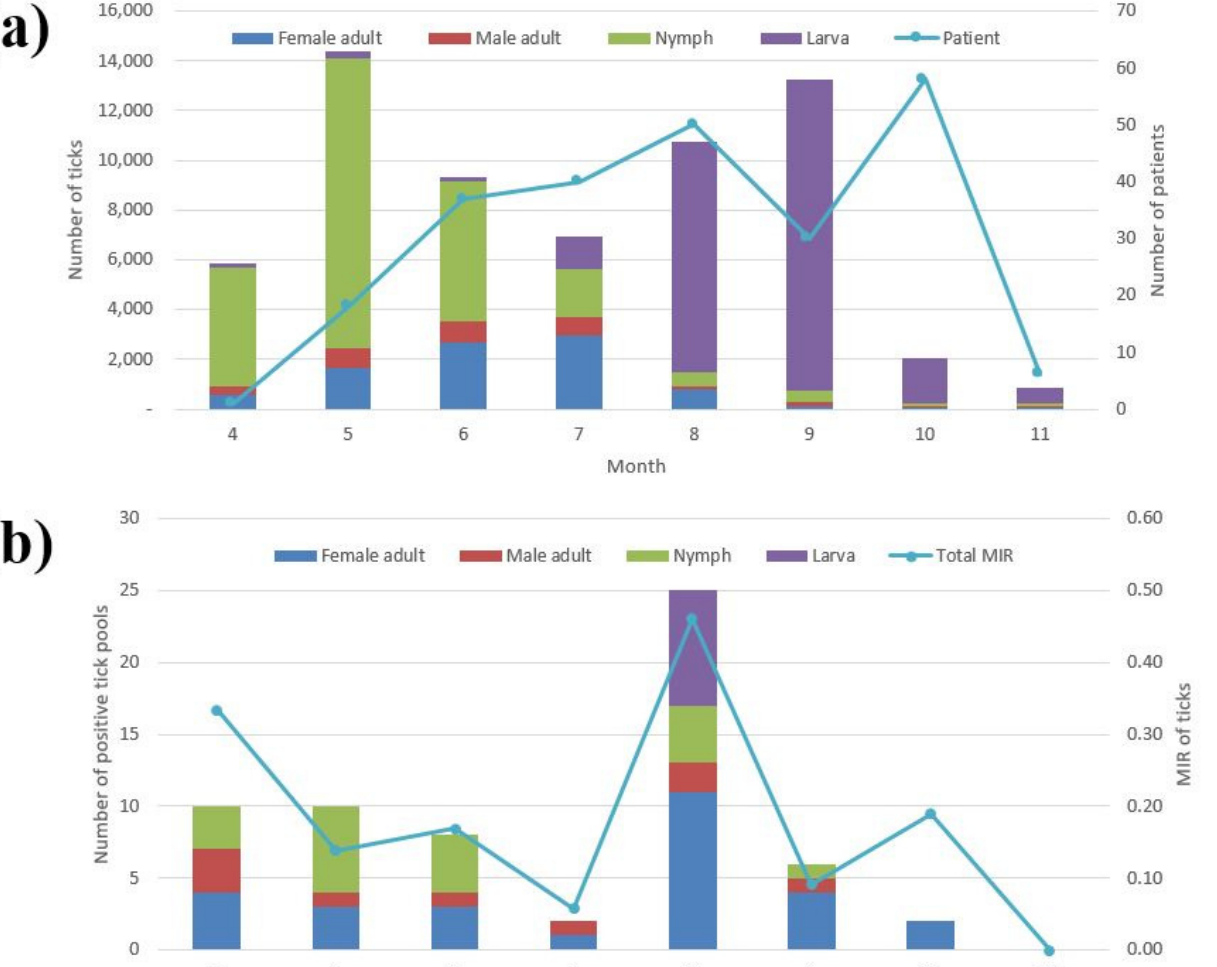
Figure 3. Temporal distribution in the populations of total ticks and SFTS patients ( a ) and the number of positive tick pools and MIR of ticks ( b ) collected from traps in Korea from April to November in 2020. MIR, minimum infection rate (number of positive pools of ticks/total number of ticks tested × 100).